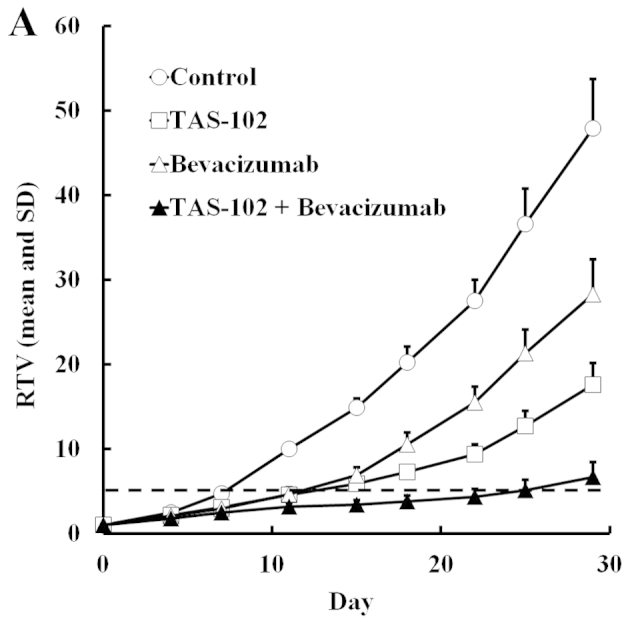
Relative volume change in human SW48 colorectal tumors (A), and body weight change in SW48 tumor-bearing nude mice (B). Mice were treated with vehicle (○), TAS-102 (□), bevacizumab (△), or combined TAS-102 and bevacizumab (▲). The values indicate the means + SD (n=6). The horizontal dotted line indicates an RTV of 5. RTV, relative tumor volume.